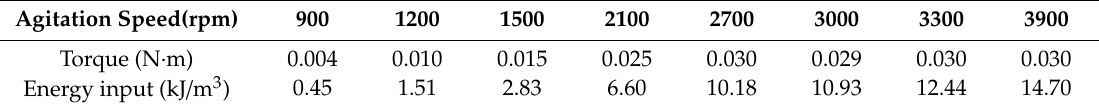
Table 2. Torque and energy input values under different agitation speed.